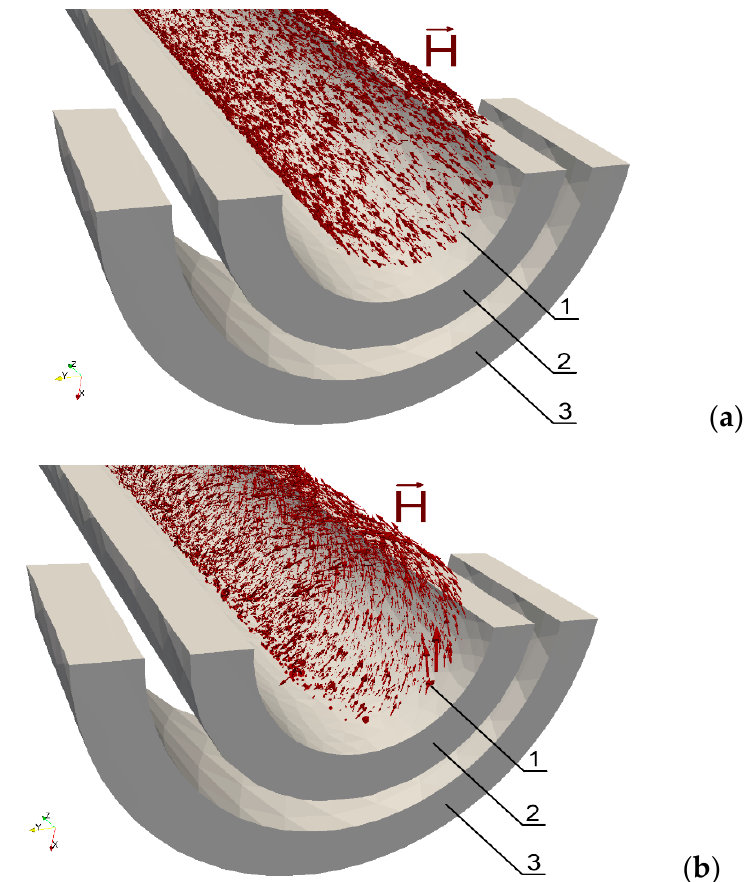
Figure 3. Magnetic field strength inside the shaft (first cross-section along the shaft axis and the second perpendicularly to the shaft axis, through the center of the length of the shaft and the coils) for different values of torque M : ( a ) M = 0 Nm, ( b ) torque M = 1.3 Nm; 1—shaft (transparent), 2—magnetizing coil, 3—sensing coil.